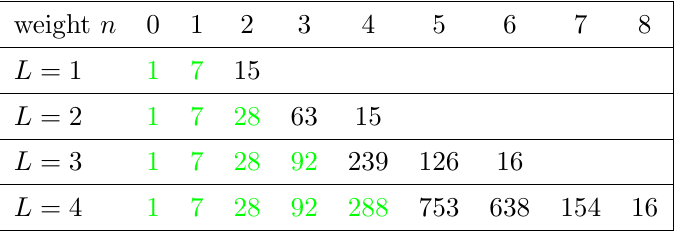
Table 2 . Number of independent parity-even f n; 1 ; 1 ; : : : ; 1 g coproducts of the MHV and NMHV seven-point amplitudes together through L = 4 loops. A green number denotes saturation of the space constructed from the bottom up.